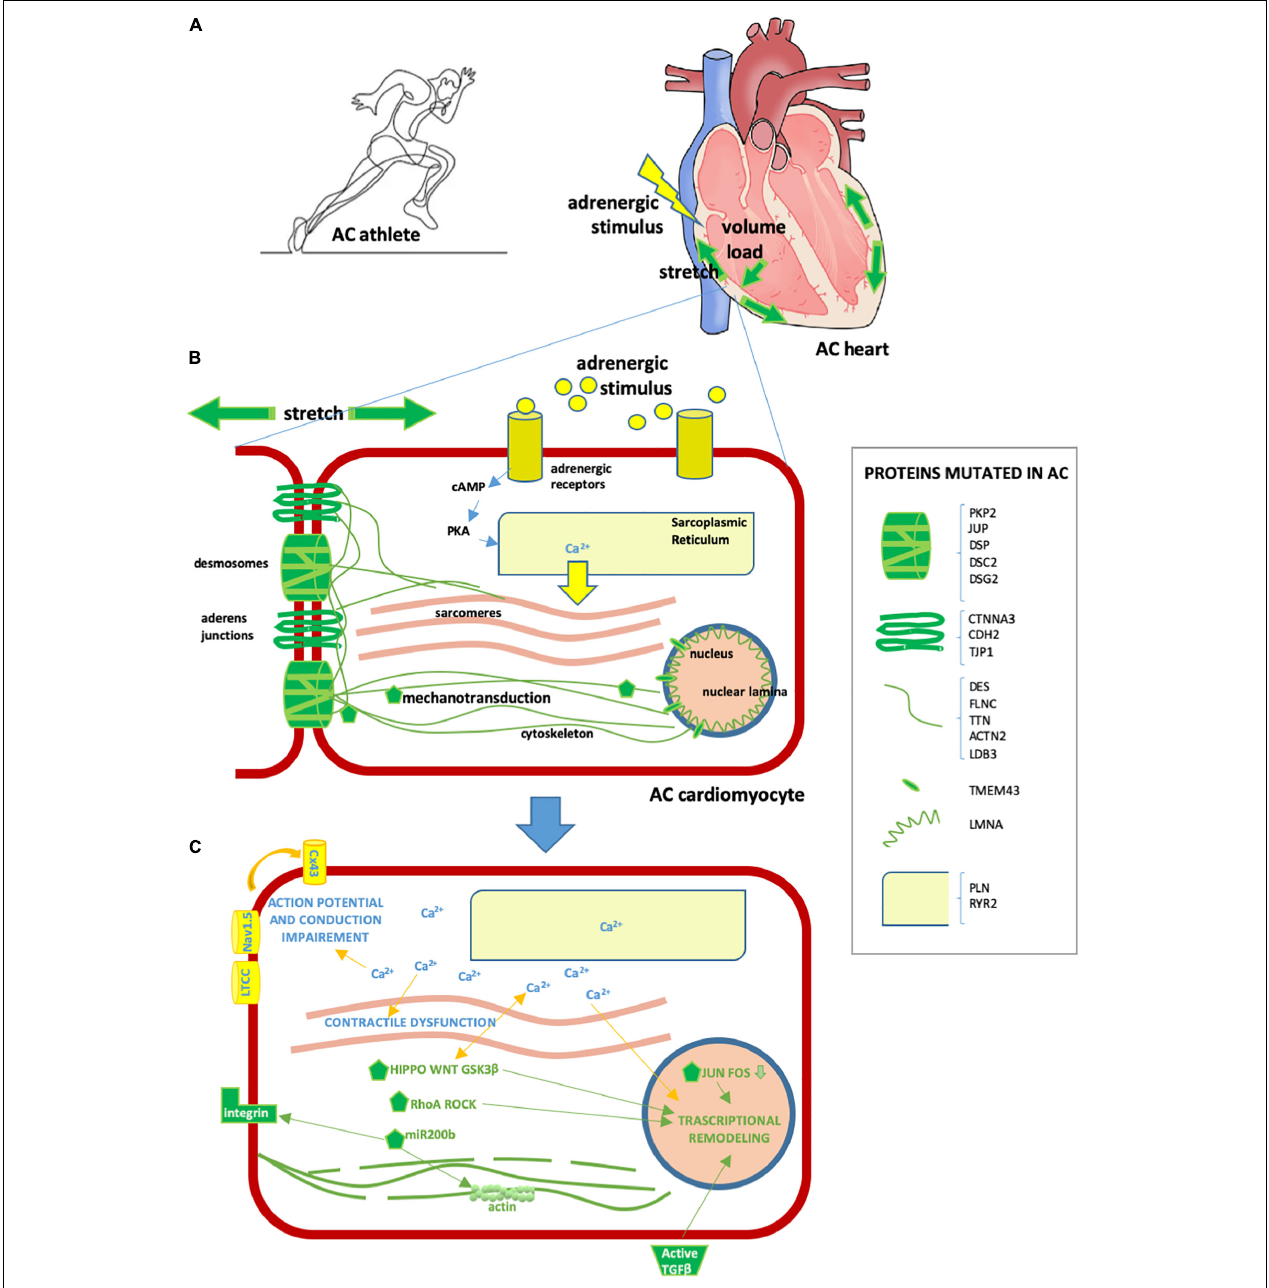
FIGURE 2 | Effect of exercise on the AC heart. (A) Exercise involves hyperactivation of adrenergic stimuli and augmented mechanical forces, including stretch and volume load. These physiological mechanisms can exacerbate AC heart remodeling and arrhythmia predisposition, already induced by AC mutations. (B) AC cardiomyocyte. In yellow/light blue, adrenergic stimuli or proteins implicated in adrenergic response [some proteins regulating calcium (Ca 2 + ) fluxes can be mutated in AC, as detailed in the box on the right]; in green, stretch or mechanical stretch responsive proteins (some proteins implicated in mechanical force management can be mutated in AC, as detailed in the box on the right). (C) Consequences of cytoplasmic Ca 2 + excess and activation of mechanotransduction molecules in AC cardiomyocytes are as